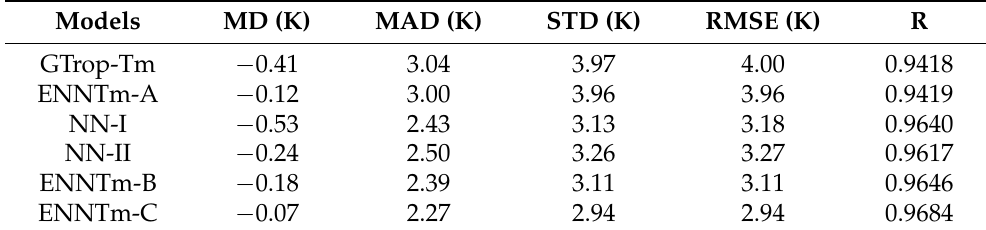
Table 3. The accuracies of different models validated by test samples below 100 m above the Earth’s surface during 2017 and 2018.